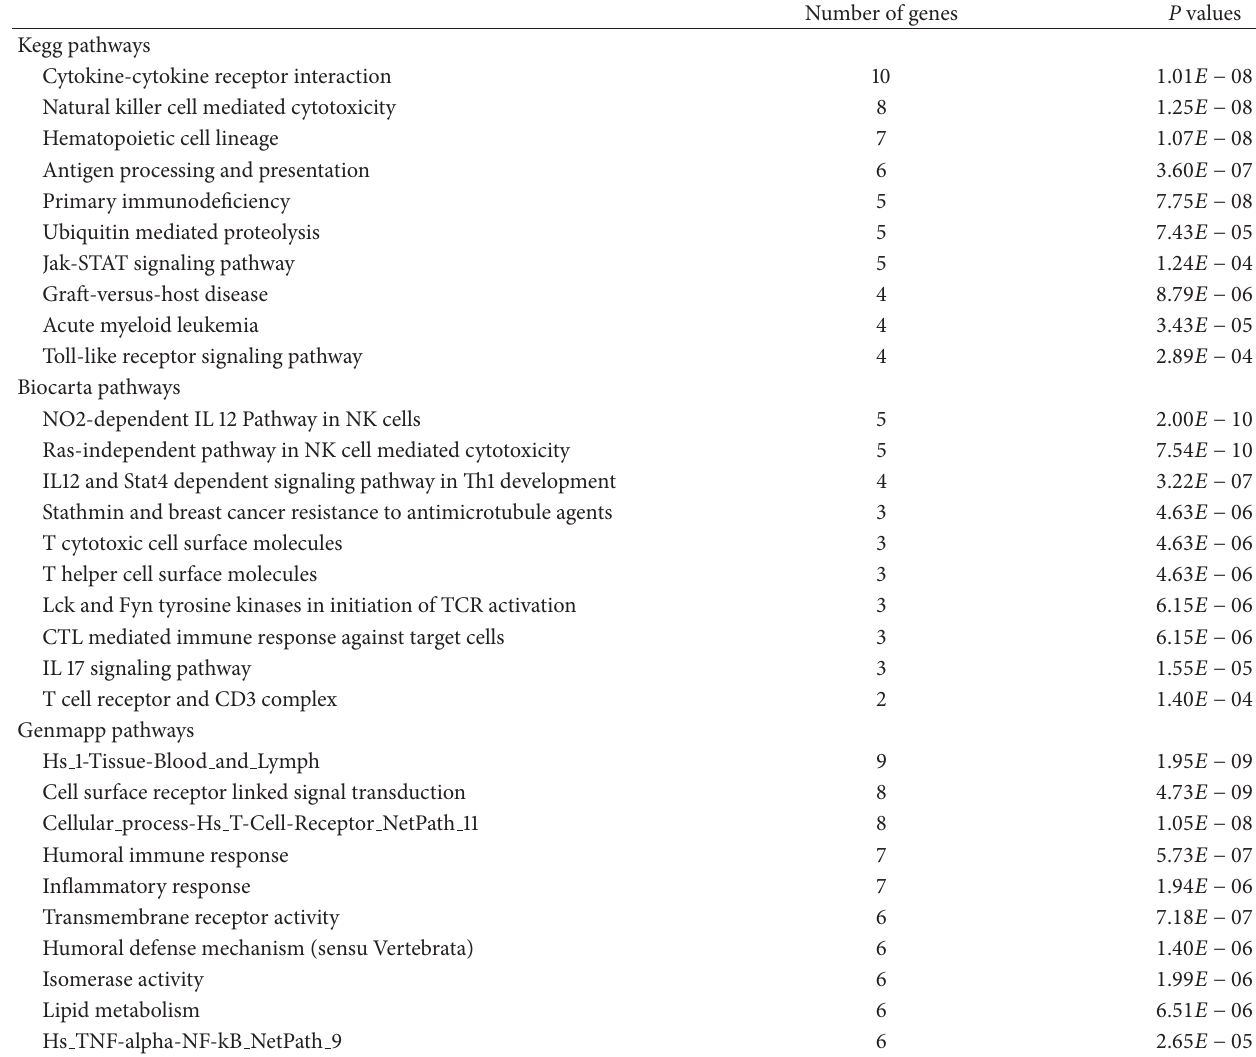
Table 4: Top ten enriched signaling pathways with significant association with DEGs (healthy